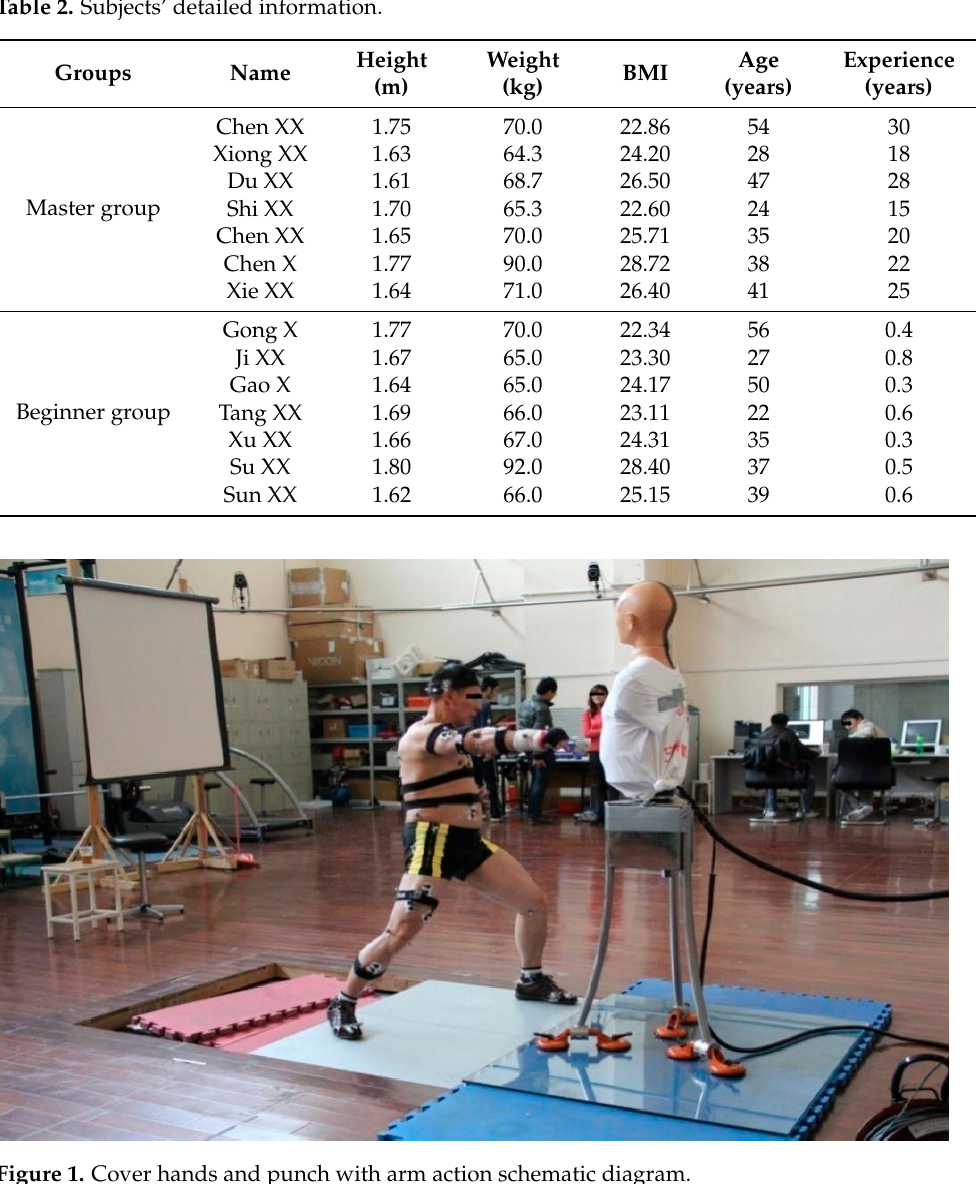
Table 1. Subjects’ basic information.